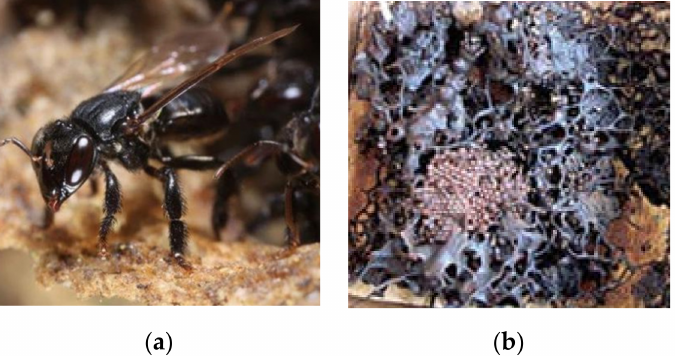
Figure 1. ( a ) Stingless bee honey; ( b ) hive containing stingless bee